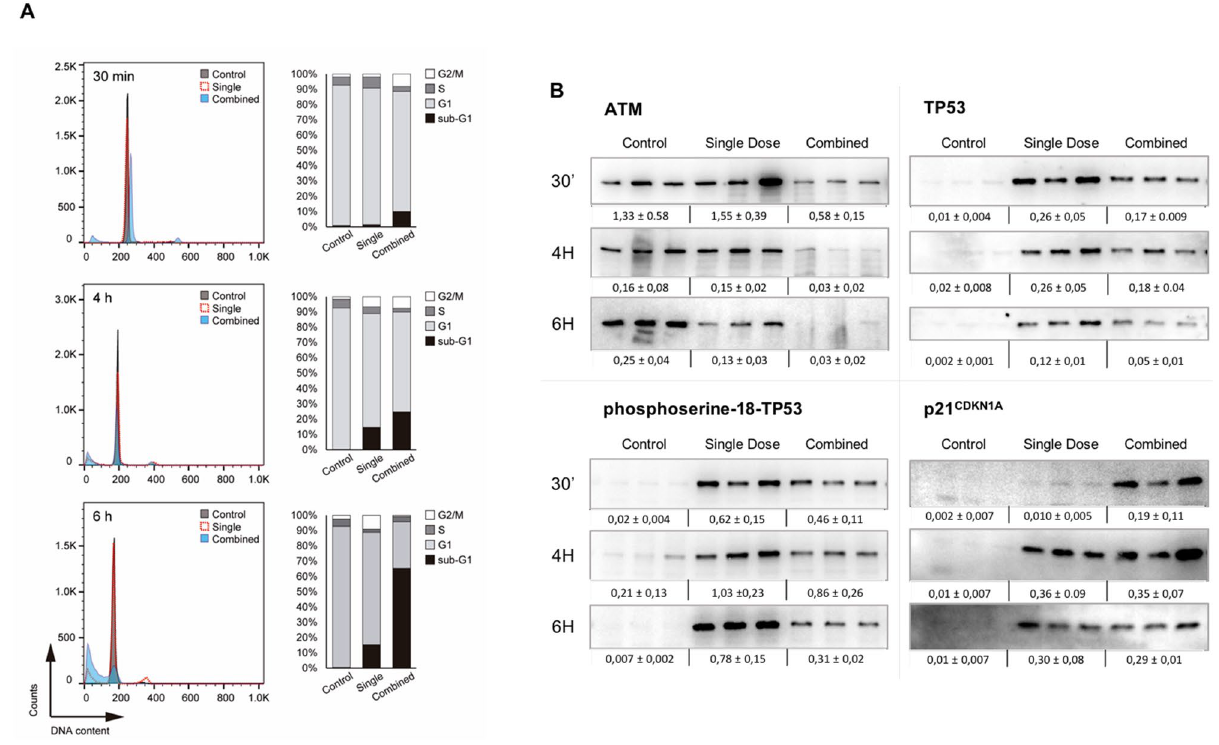
Figure 1. In vivo proliferation study of mouse thymocytes after a single or combined radiation regime. ( A ) Cell cycle analysis using flow cytometry. Propidium iodide (PI) staining of thymocytes for each radiation regime. Representative plot depicted for each time point (left panels) and the mean of 3 biological replicates (right panels). Control cells, single dose (1.75 Gy) and combined regime (0.075 Gy + latency + 1.75 Gy) at the different times assayed after the end of each regime, 30 min (upper panels), 4 h (center panels) and 6 h (lower panels). ( B ) Western blot analysis of several proteins of the ATM-TP53-phosphoserine-18-TP53 axis. Radiation dose- response and time-dependent protein expression of ataxia telangiectasia mutated protein (ATM) (350 kDa); tumor protein p53 (TP53) (53 kDa); phosphoserine-18-TP53 and p21 CDKN1A (21 kDa) . Blots show 3 biological replicates for each radiation regime. β-Actin was probed as a loading control for each membrane as shown in annexed Fig. 1. Original blots are presented in supplementary